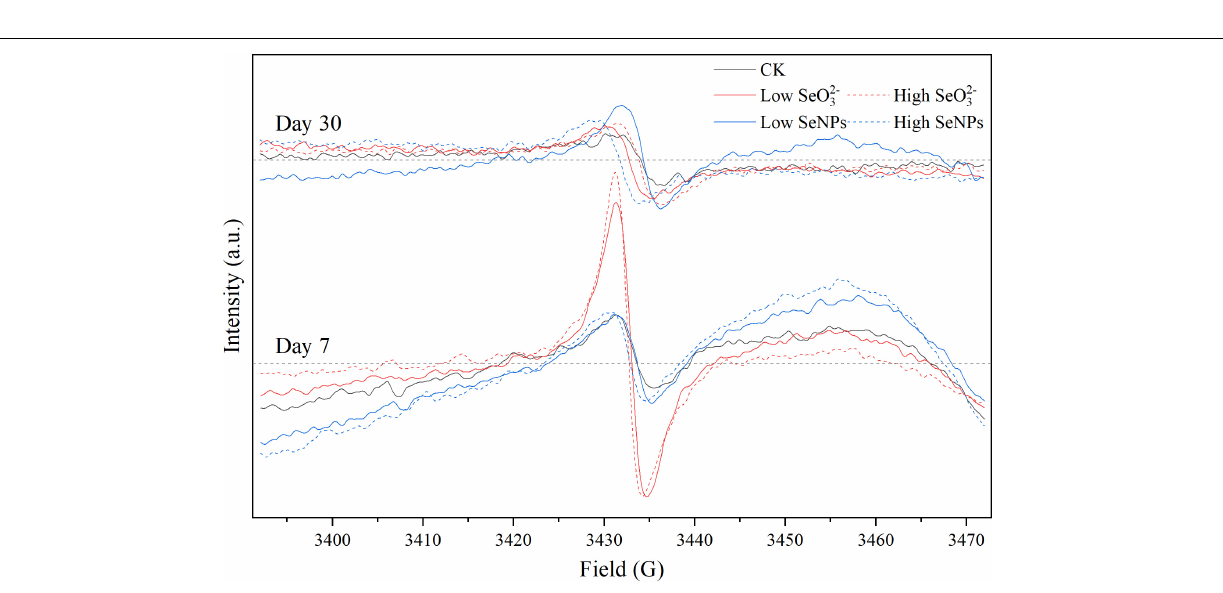
Frontiers in Microbiology |